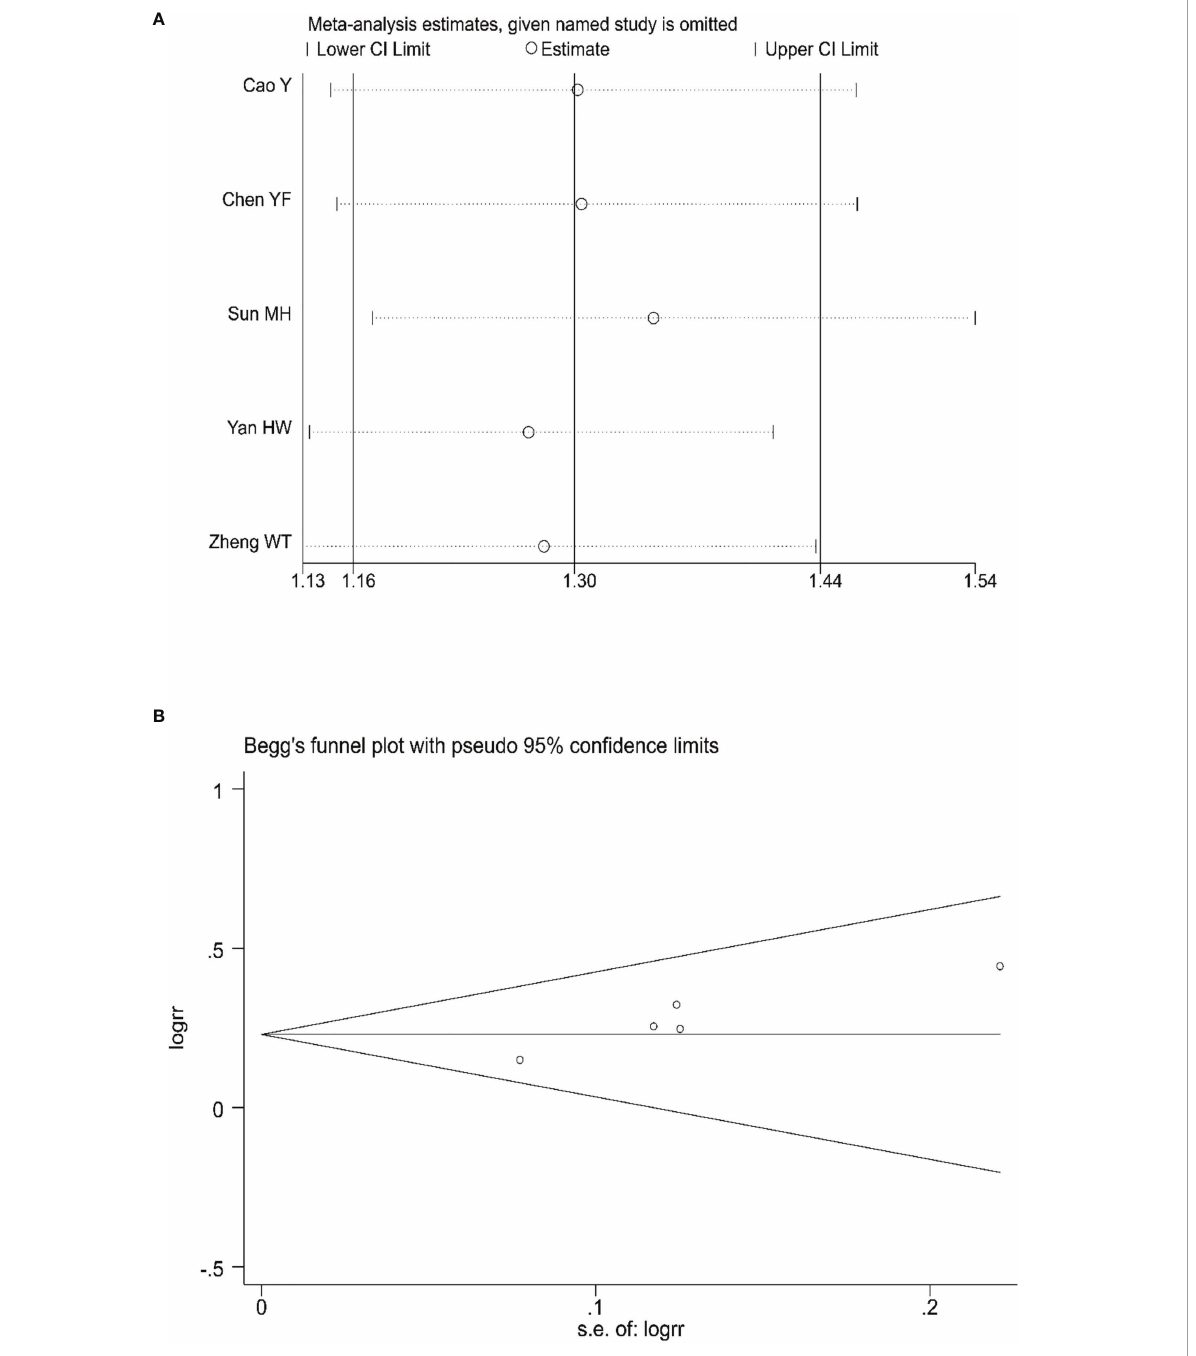
FIGURE 9 Sensitivity analysis (A) and Begg ’ s funnel plot (B) for the analysis of ORR. (Begg ’ s test: P= 0.221). ORR, objective response